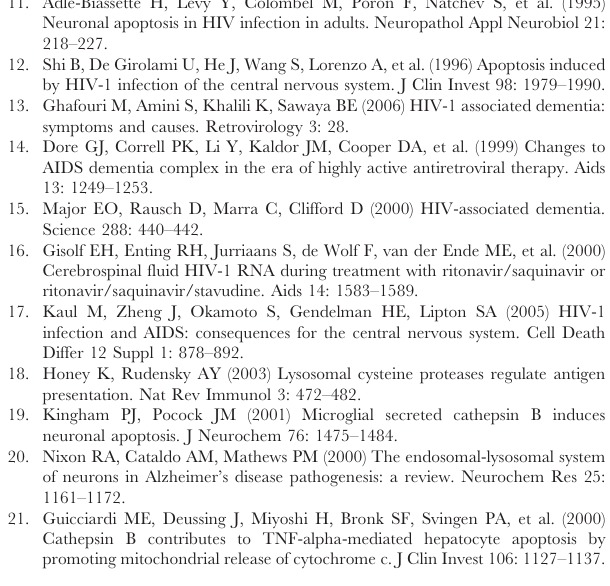
Figure S2 Neurofilament staining of SK-N-SH cells in culture. SK-N-SH neuroblastoma cells were cultivated in slide chambers, and fixed with a methanol/acetone solution. Primary antibody MAB 5266 MS x Neurofilament 200 kD (Chemicon Temecula, CA) was used to stain heavy neurofilaments at 1:1000 dilution followed by 1 hr incubation at room temperature. A secondary antibody (Alexa 488 Goat Anti-Mouse IgG) was added at 1:2000 dilution and incubated for 1 hour at room temperature. DAPI was used for nuclear staining (blue). Panels A to E represent different fields to demonstrate that SK-N-SH show evidence of maturation by positive neurofilament staining. Confocal images were obtained on a Zeiss confocal microscope Axiovert 200 M with a LSM 510 with 63 6 magnification (panels A and B) with a 2.5 zoom amplification (panels C to